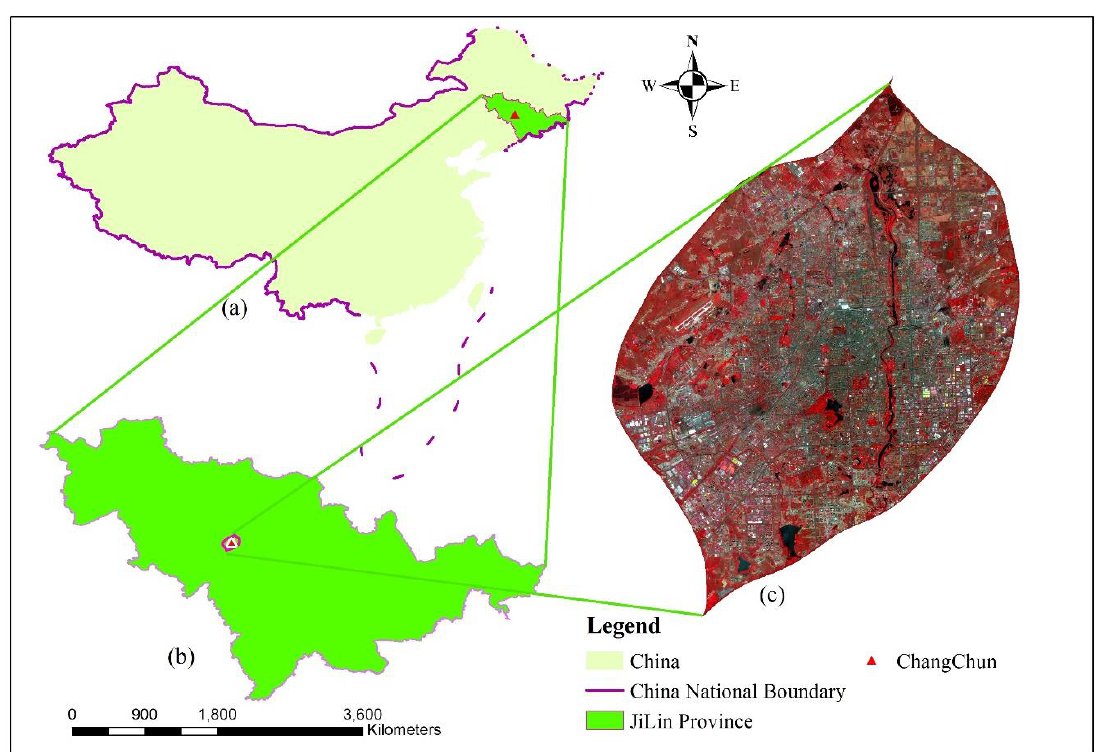
Figure 1. The study area (standard false color composition from GF-1 satellite imagery).